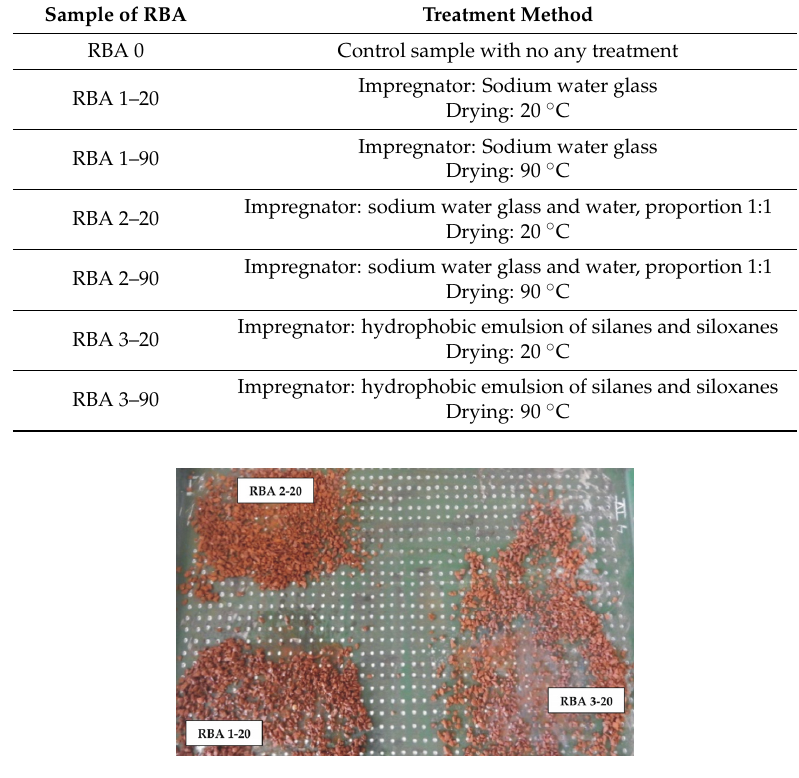
Figure 3. Treated recycled brick aggregate (RBA) samples after drying at 20 °C.